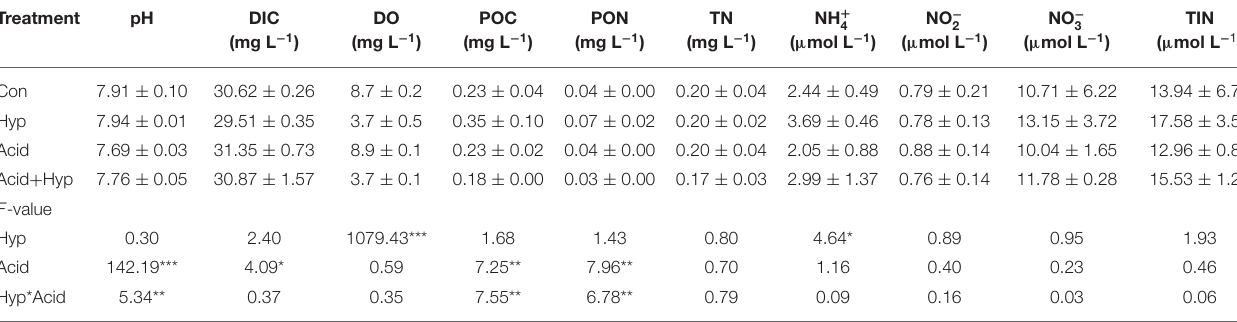
TABLE 2A | Effects of ocean acidification and hypoxia on chemical properties of seawater samples at the Dongjiang port.